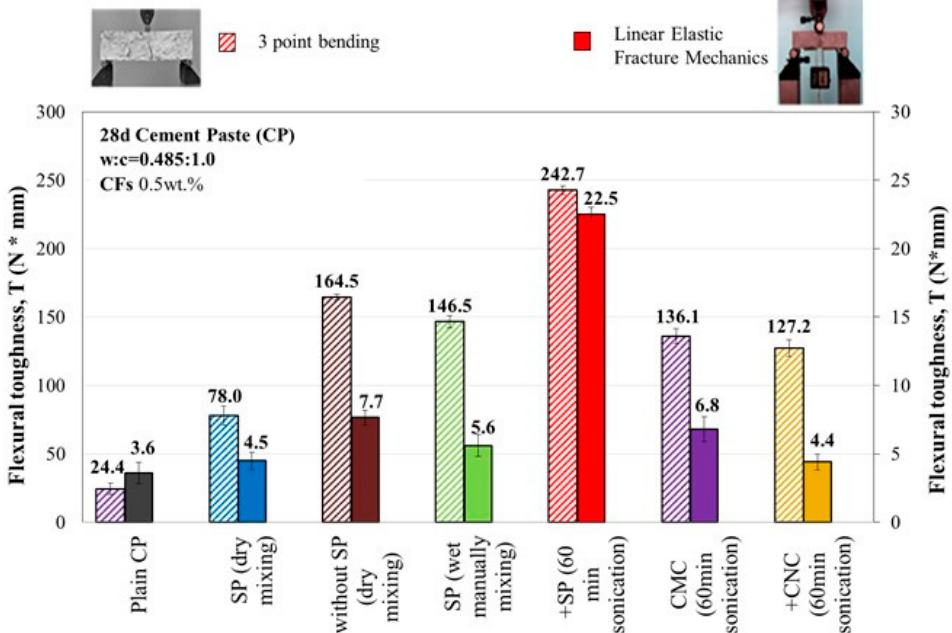
Figure 18. Flexural toughness of the 28-day cement pastes as estimated from the area under the load-deflection (three-point bending) and load-CMOD curves (LEFM).